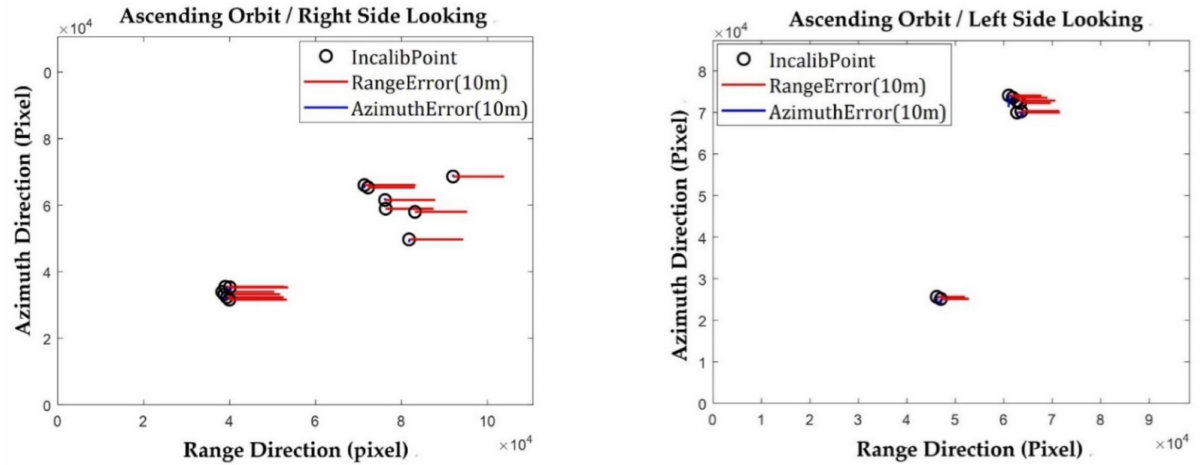
Figure 10. Range and azimuth calibration deviations of all corner reflectors inside a single image (Left: Incalib Image 11; Right: Incalib Image